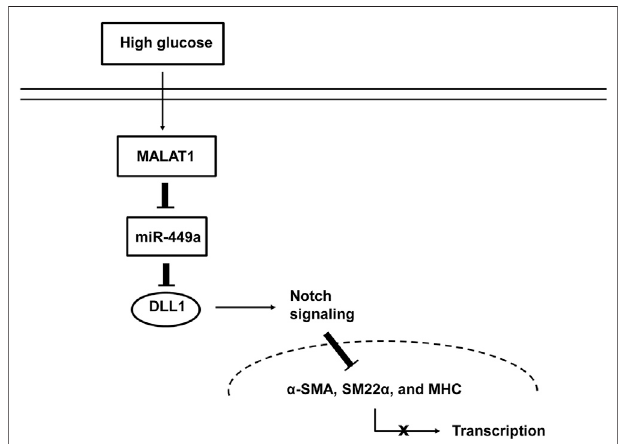
FIGURE 7 | Proposed mechanism by which MALAT1 regulates the phenotypic switch of HGSMCs under HG condition.